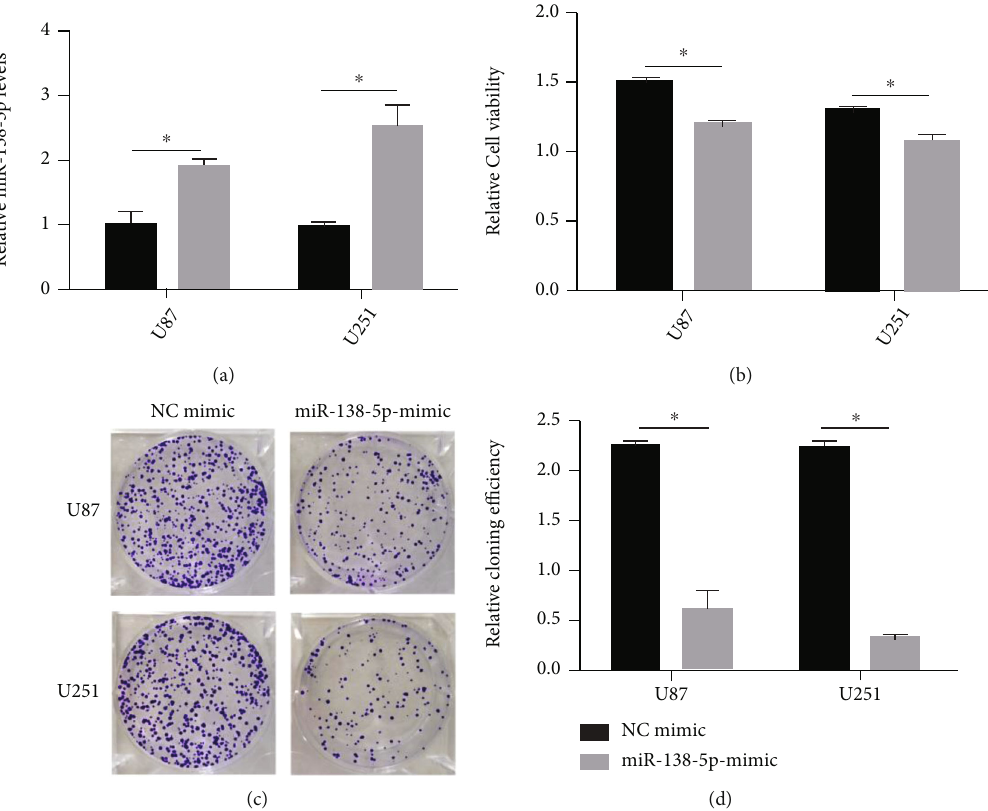
Figure 1: E ff ects of miR-138-5p on proliferation and apoptosis of U87 and U251 cells. (a) miR-138-5p transfection increased miR-138-5p levels in U87 and U251 cells compared to NC-transfected cells. (b) Cell viability of U87 and U251 cells was determined by a CCK-8 assay. (c, d) Colony formation experiments showed that the absorbance (OD value) of U87 and U251 cells decreased at 550nm after forced expression of miR-138-5p. Each experiment was repeated at least three times. ∗ P < 0 : 05